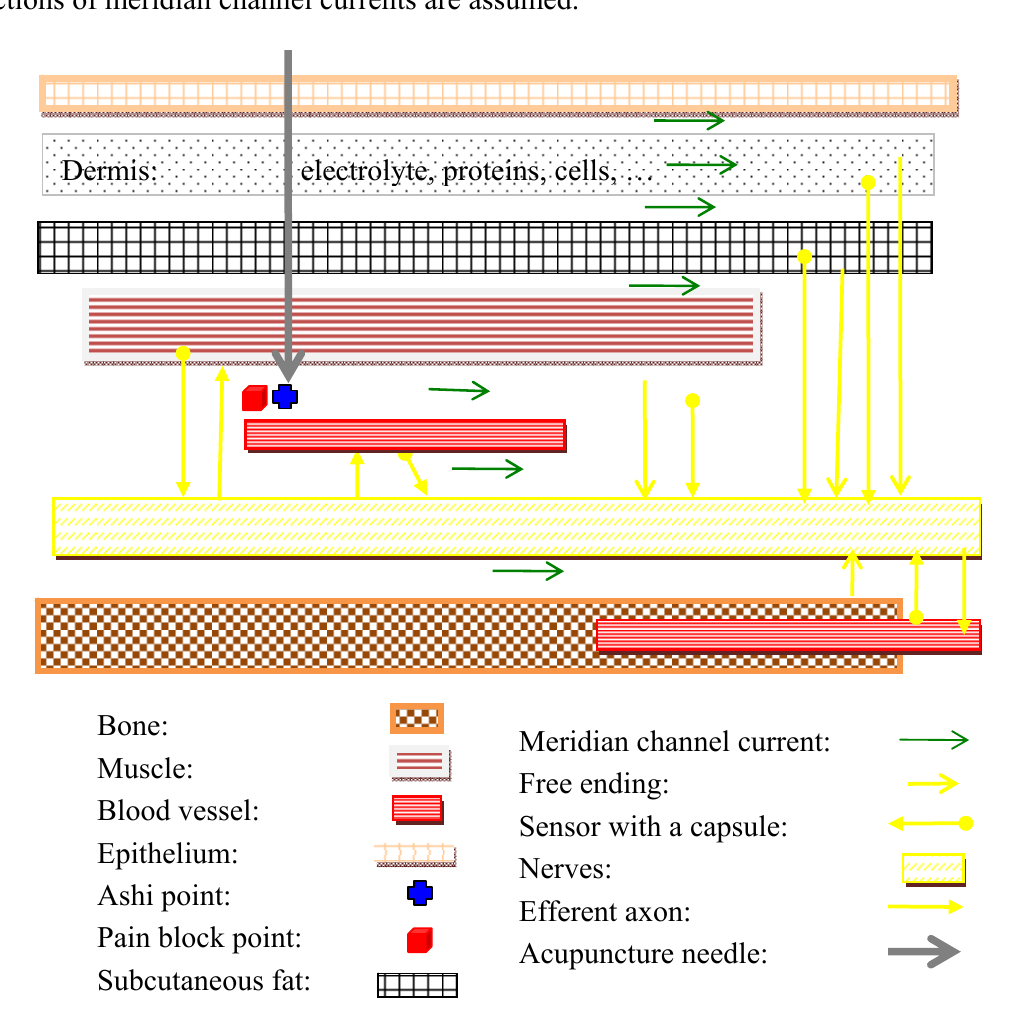
Figure 1. Our model of acupuncture (or EA) point. The ashi point is at the pain point. The directions of meridian channel currents are